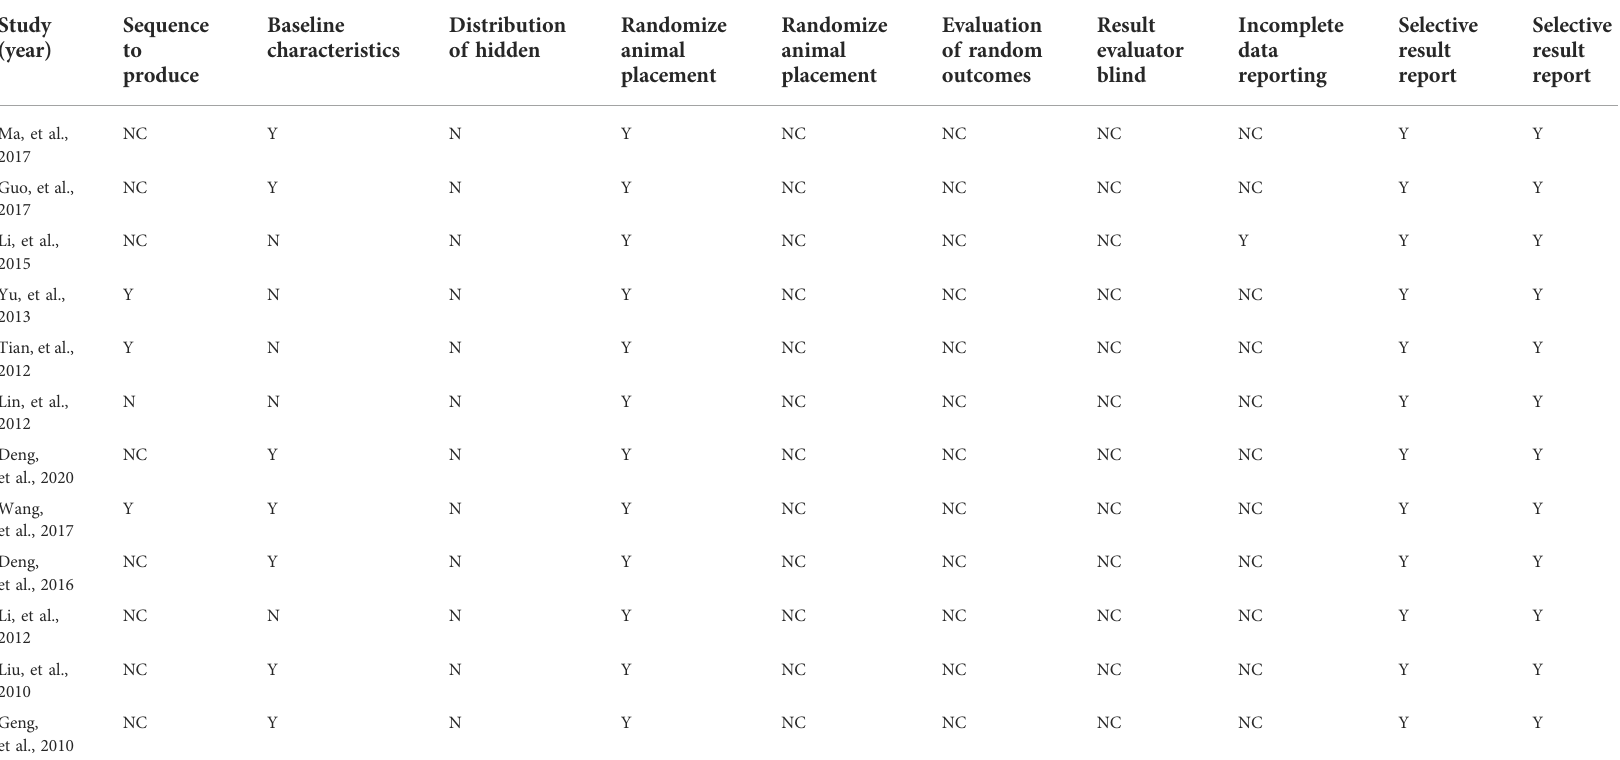
TABLE 2 Results of SYRCLE ’ s risk of